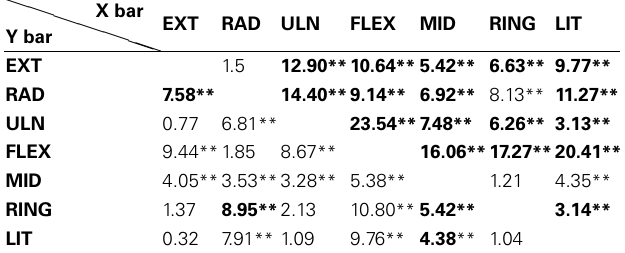
Table 1 | Comparison of the barycenter position among contractions. (cid:2) (cid:2) (cid:2) (cid:2) (cid:2) (cid:2)(cid:2) Y bar